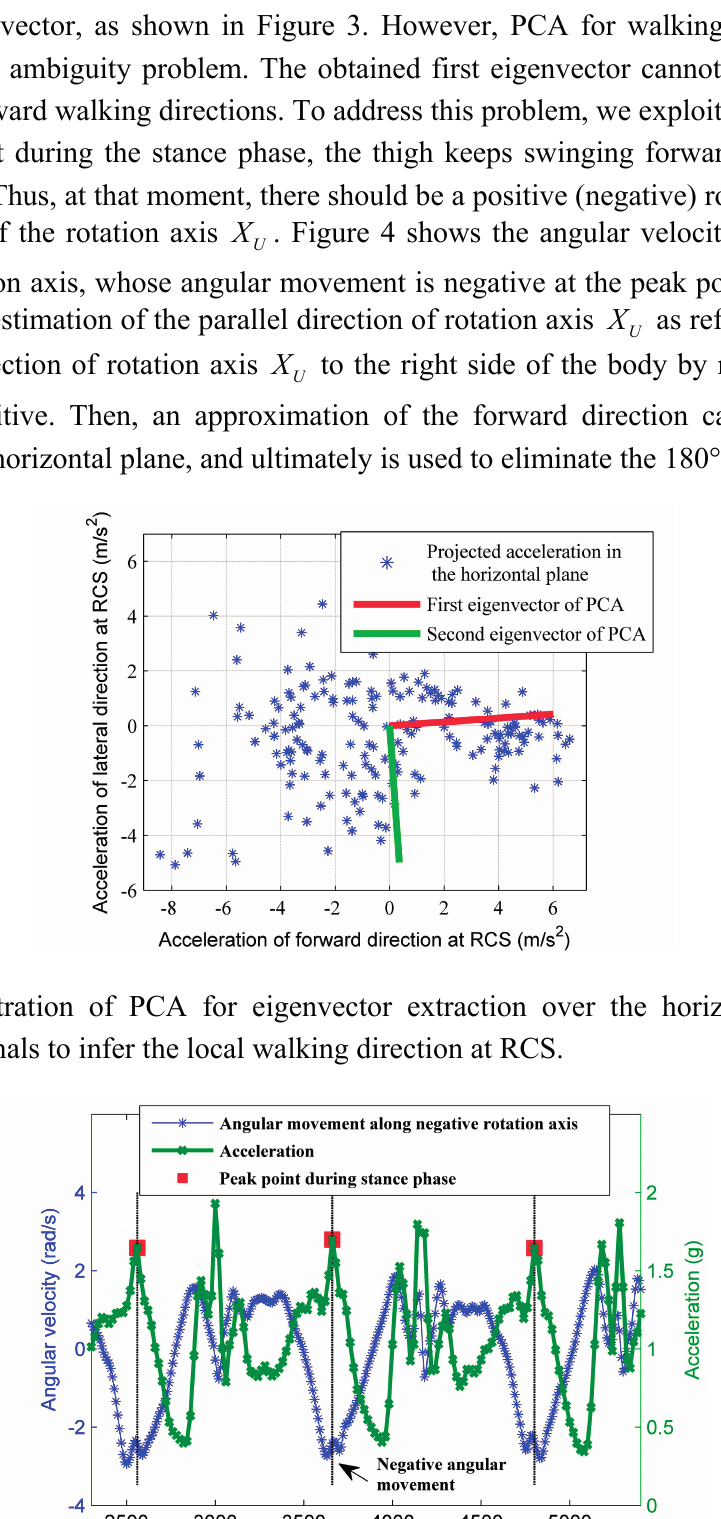
Figure 4. The rotation value along the negative (positive) direction of the rotation axis should be negative (positive) at the peak point during stance phase. This can be used to align the positive direction of the rotation axis